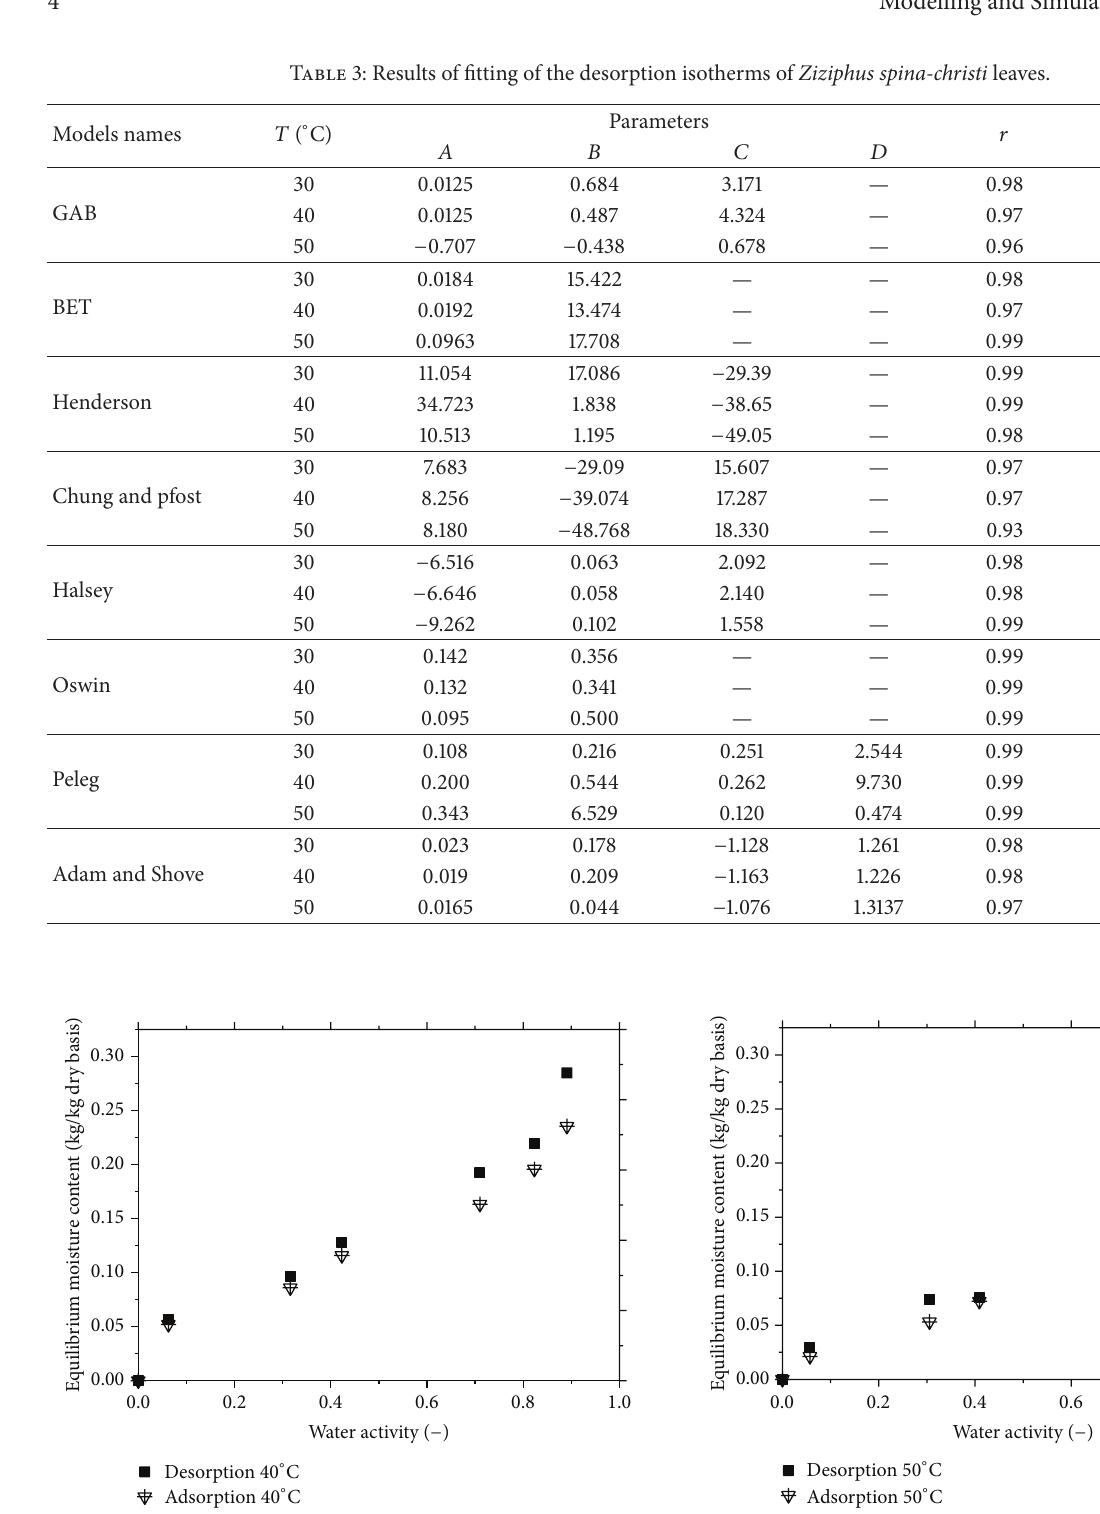
Figure 2: Desorption and adsorption isotherms of Ziziphus spina- christi leaves obtained at 40 ∘ C. Des: desorption; Ads: adsorption.